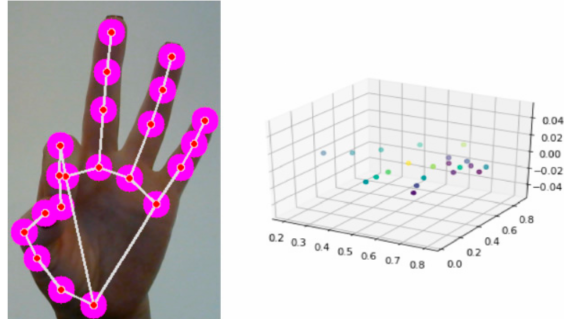
Figure 10. An example of data visualization of some classes.